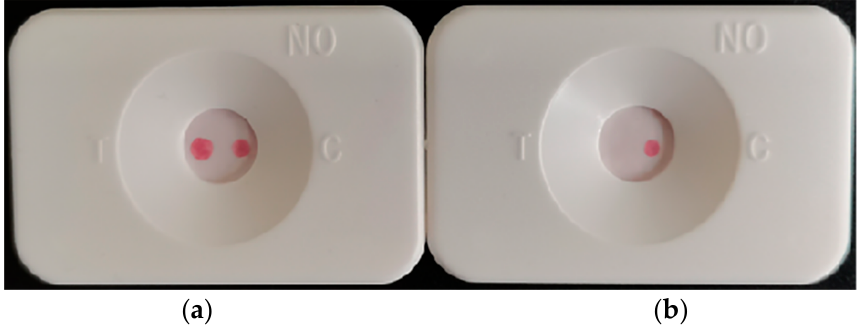
Figure 3. ( a ) Positive result (left); ( b ) Negative result